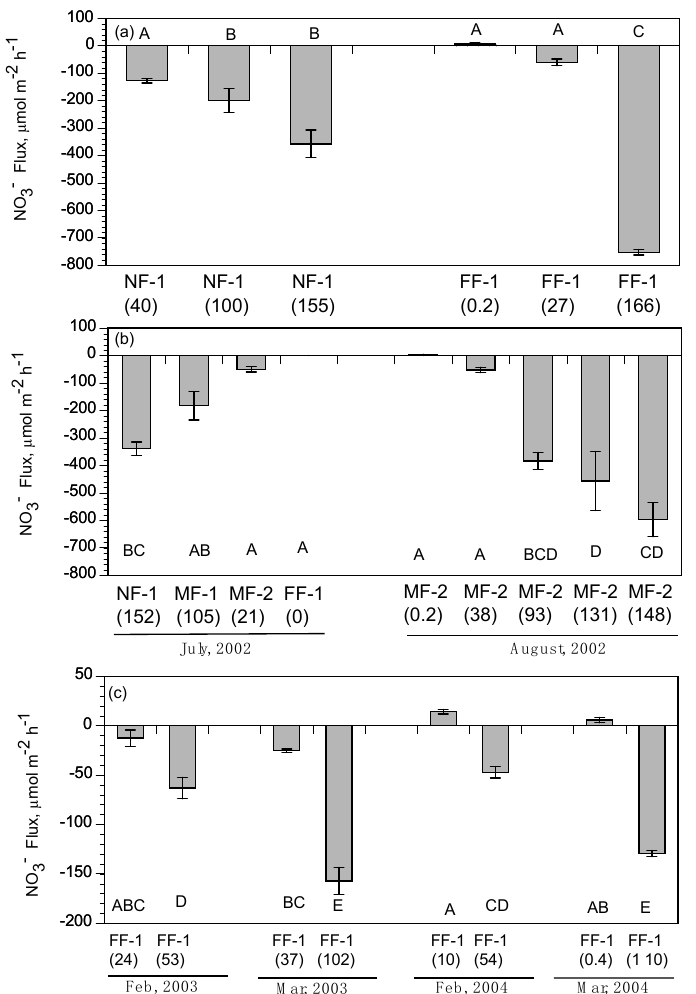
Figure 6. Subtidal benthic fluxes of nitrate (NO 3 − ) in field manipulations of changing nitrate concentrations in overlying water at different benthic sites. Treatments are defined by site location (NF = near-field, MF = mid-field, FF = far-field) treated with different concentrations of nitrate (concentration is value in parentheses, μ M). ( a ) NF-1 and FF-1 sites manipulated by adding enrichments of NO 3 − . ( b ) NF, MF and FF stations during July 2002 and MF station with ambient (0.2 μ M NO 3 − ) water enriched with different concentrations of NO 3 − in August 2002. ( c ) FF-1 station with ambient water compared to water from Big Mar during each of four pulse experiments including February 2003 and 2004, and March 2003 and 2004.